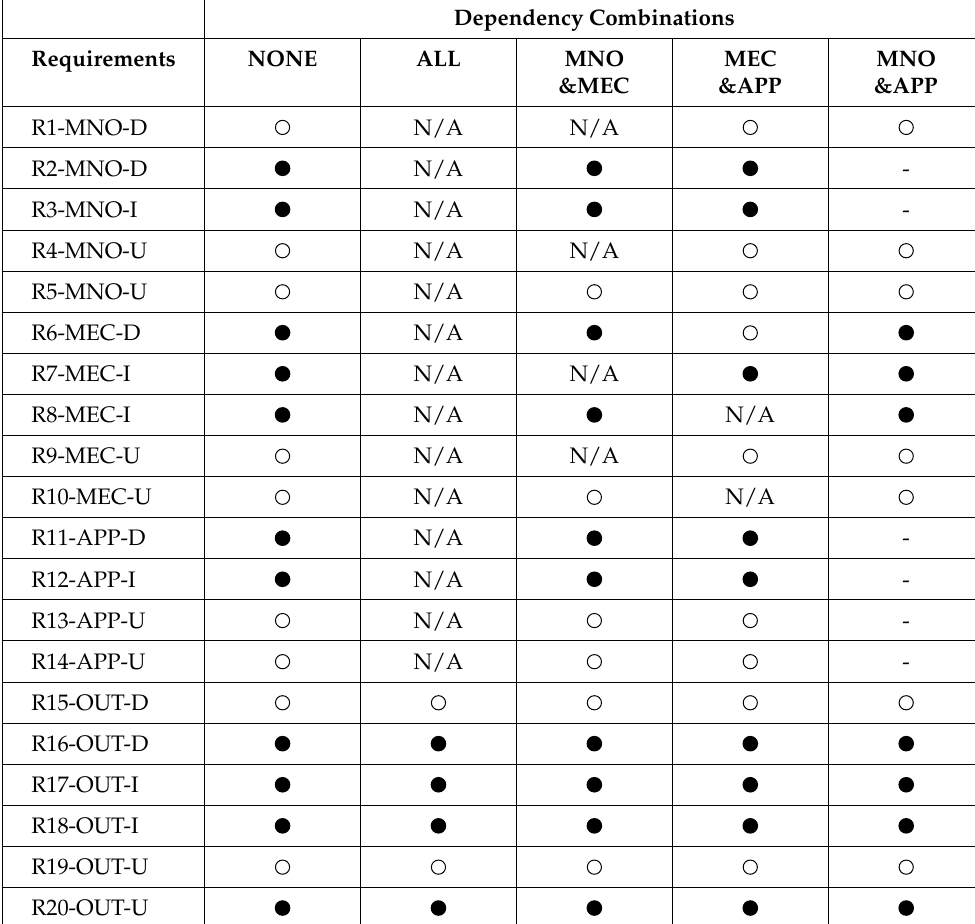
Table 1. Effect of dependency combinations on applicability of the privacy requirements and how the solution fulfills them. Dependency